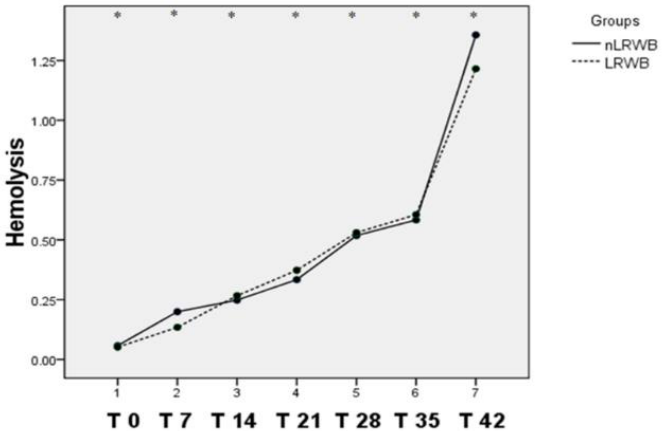
Figure 11. Basal and storage hemolysis. Differences in hemolysis (mean) measured in nLRWB and LRWB units during the storage period. The days of storage are presented in the x-axis. Hemolysis (%) is presented in the y-axis. Asterisks * p < 0.05.